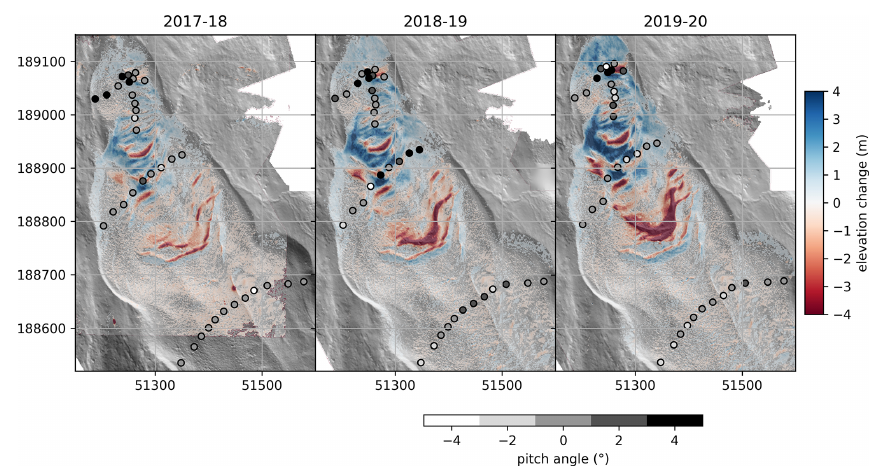
Figure 13. Pitch angle of each DGNSS block identified in the ULS data for the years 2018–2019, 2019–2020, and 2020–2021, plotted over the elevation change layer of the same time period and a hillshade of the later DSM. Black lines show the displacement vectors for the cross profiles during the three time periods.